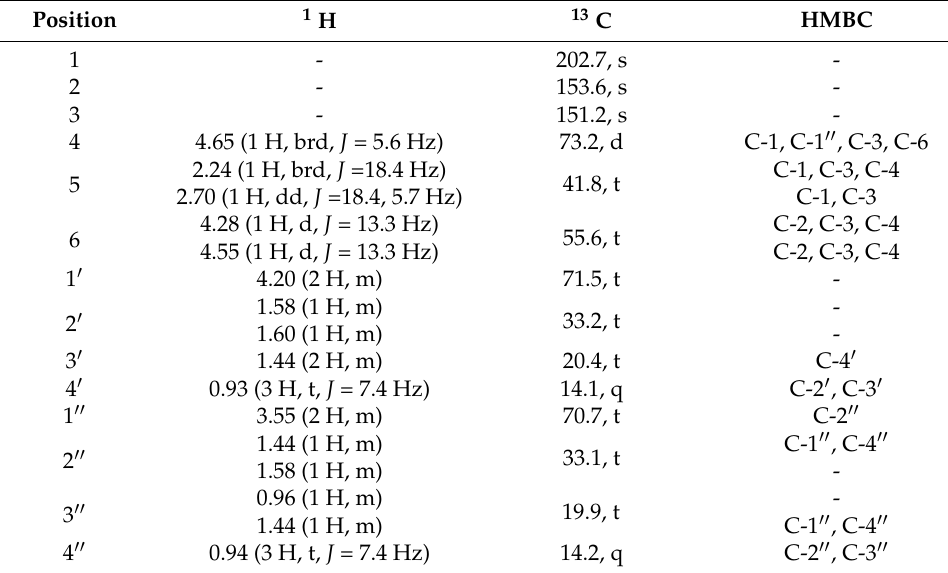
Table 1. The NMR Data of Compound 2 in CD 3 OD (600